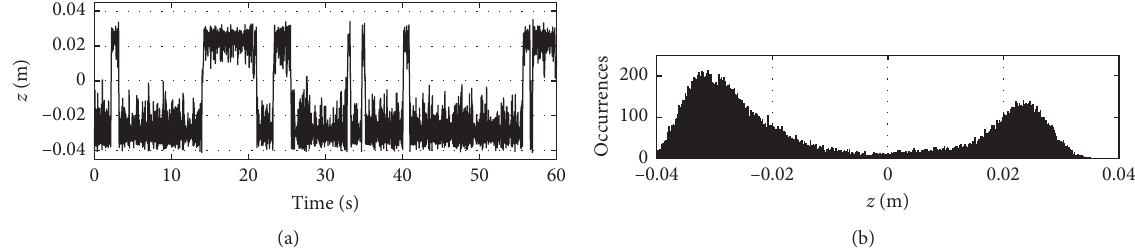
Figure 8: Random test at the highest amplitude, € b � 38m/s 2 RMS: (a) time history of the displacement (first 60 seconds); (b) statistical distribution of the displacement.